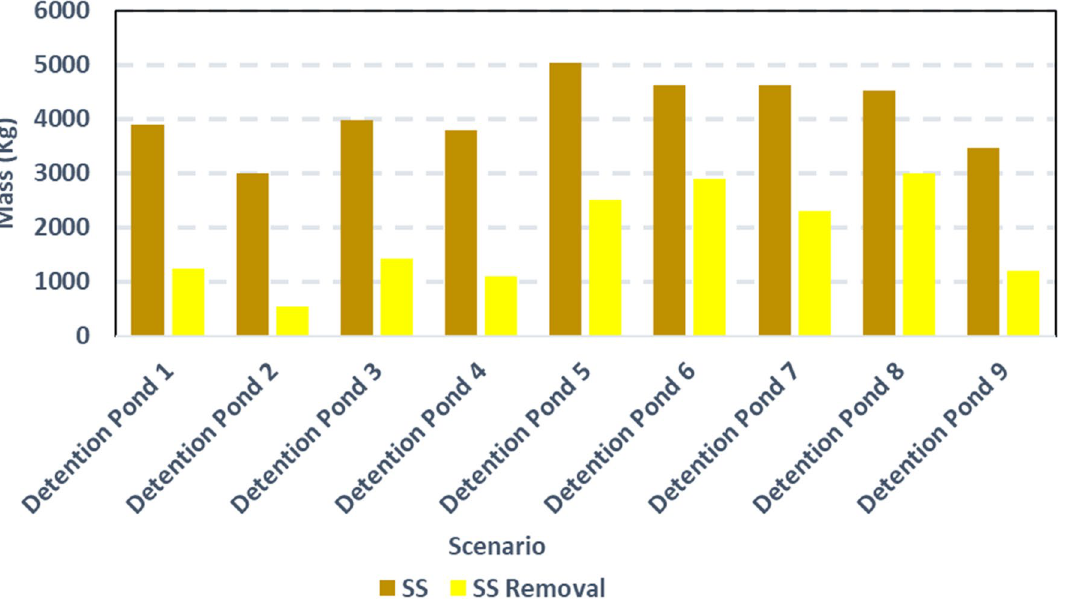
Figure 14. Simulations of Suspended Solid removal as a result of considering the implementation of detention ponds.